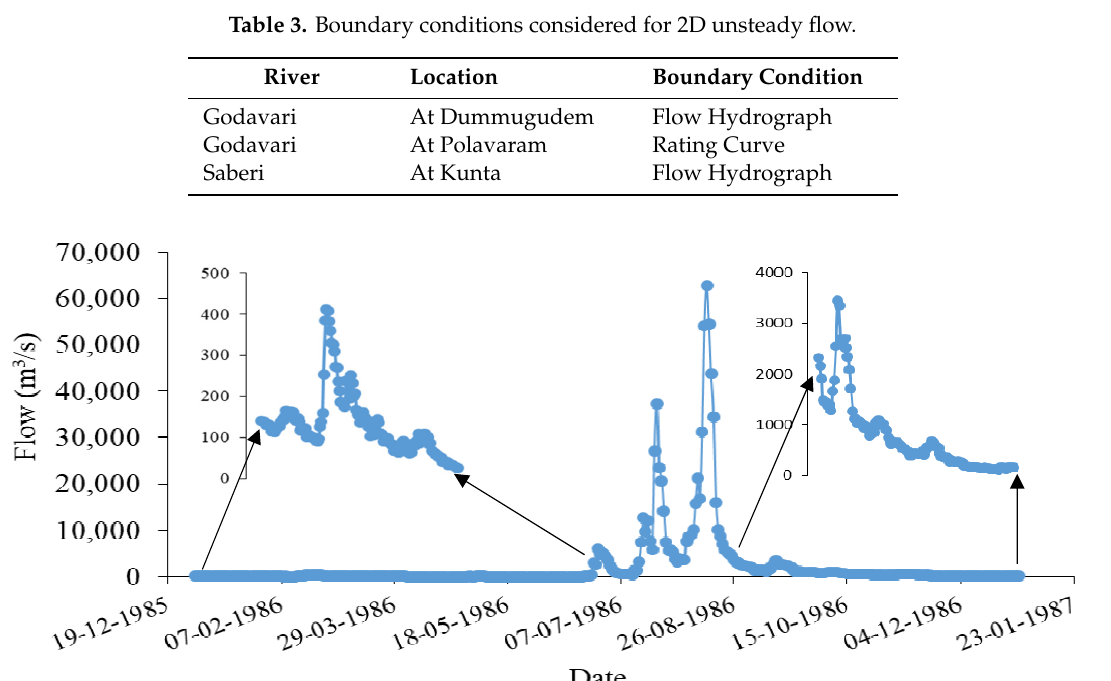
Figure 6. Flow hydrograph data considered for upstream boundary condition at Konta for the year 1986. Figure 7. Rating curve data considered for downstream boundary condition at Polavaram for the year 1986.